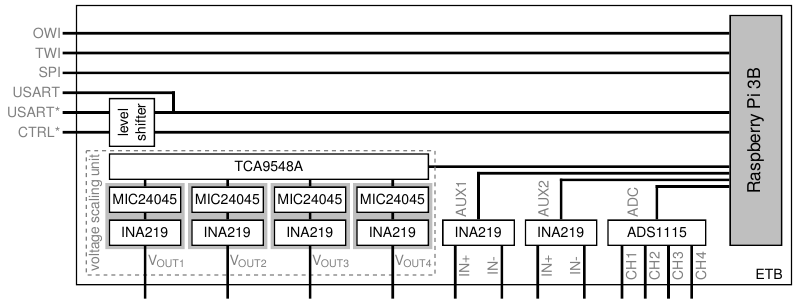
Figure 13. Basic components of the embedded testbench